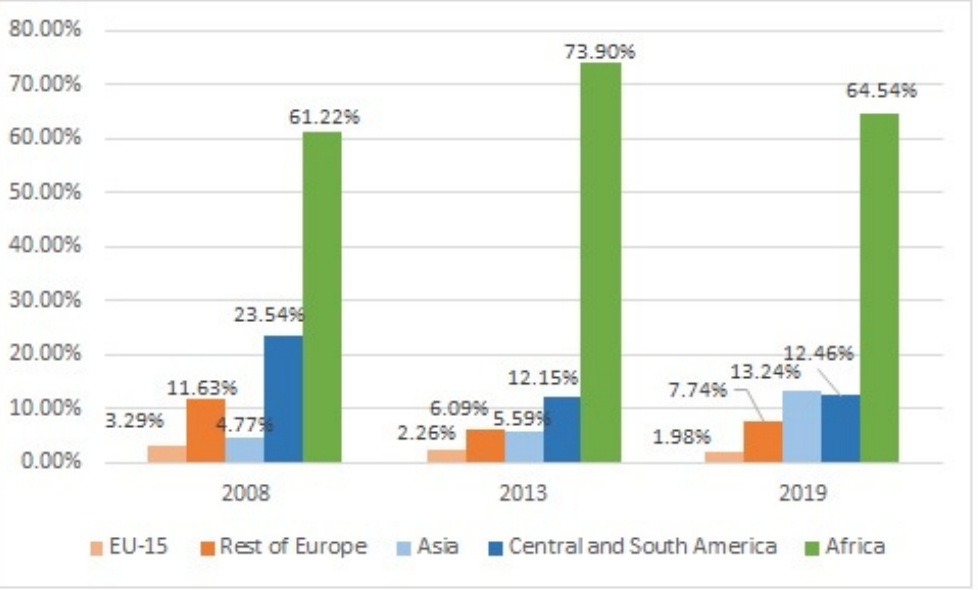
Figure 2. Son Gotleu’s foreign-born population by region of origin. Source: Prepared by the author based on data from the Spanish National Statistics Institute (INE) and the municipal census of inhabitants.